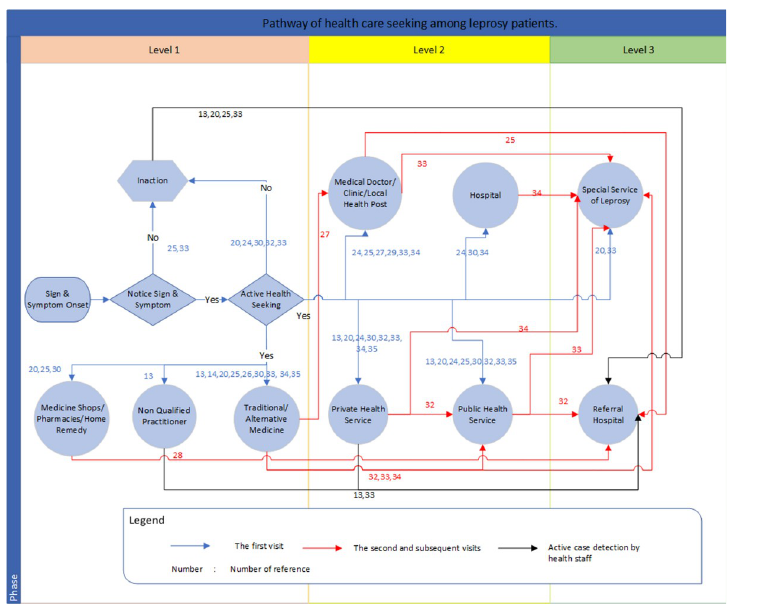
Fig 4. Pathway of health care seeking among leprosy